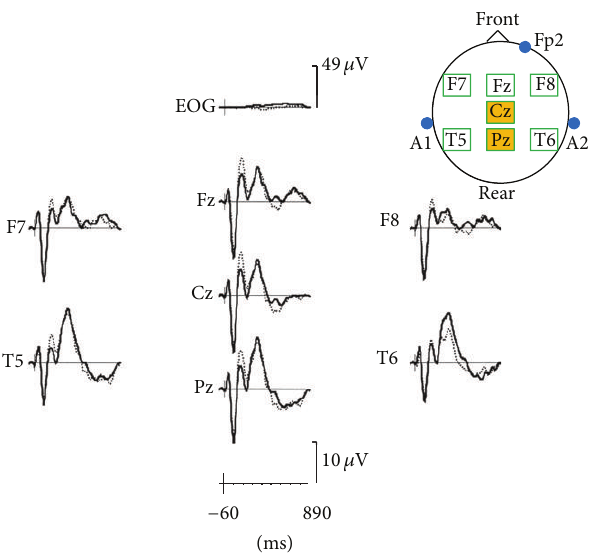
Figure 1: Average P300 of apathetic patients (full line) and nonap- athetic patients (dotted line) during OFF period. Decrease of P300 amplitude is statistically significant in Cz and Pz areas.